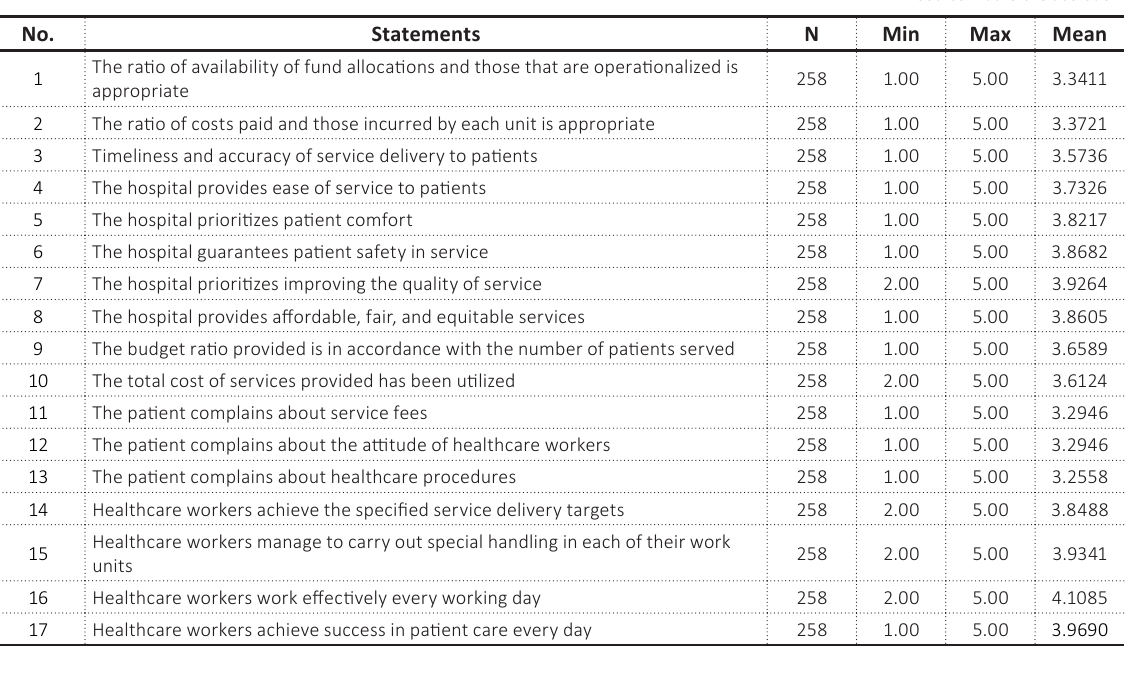
Table 4. Descriptive statistics of the organizational performance variable ( Y )